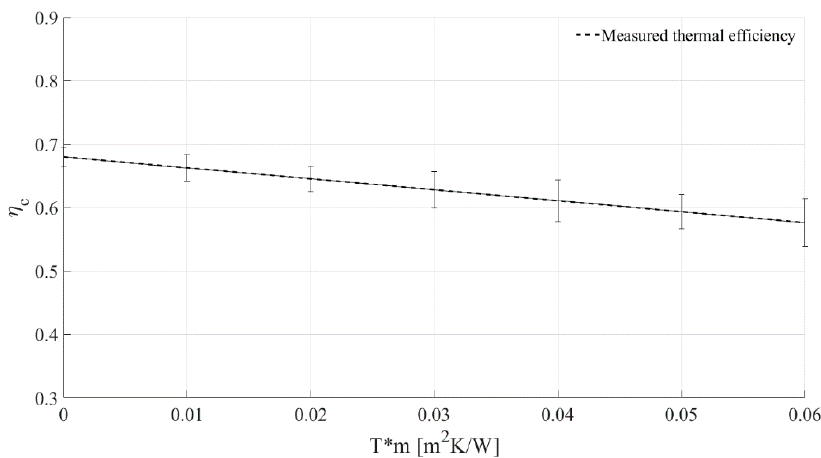
Figure 11. Thermal efficiency of the tested solar collector.